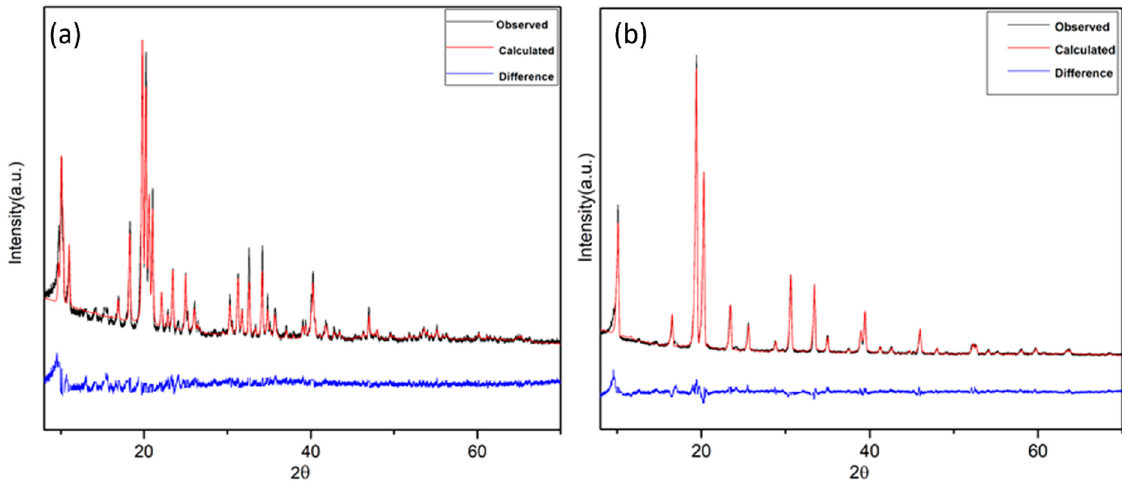
Figure 2. ( a ) Rietveld refinement of the crystal structure of Ca x Mg 1 − x Ni 2 ( x = 0.33) in the hexagonal MgNi 2 type P 6 3 / mmc , a = 482.585(27) pm, c = 1583.073(106) pm, R w p = 3.76%, χ ² = 1.85; ( b ) Rietveld refinement of the crystal structure of Ca x Mg 1 − x Ni 2 ( x = 0.5) in the cubic CaNi 2 type Fd 3 m , a = 697.116(32) pm, R w p = 3.11%, χ 2 = 1.34 based on X-ray powder diffraction at 297(1) K (Mo K α 1 radiation, λ = 70.926